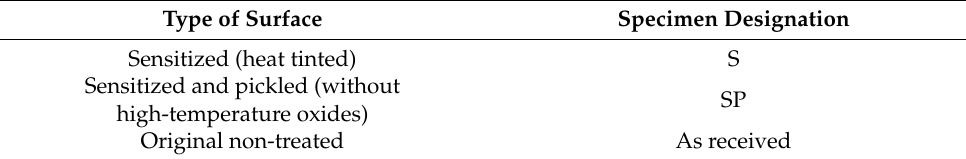
Table 4. Overview of tested specimen